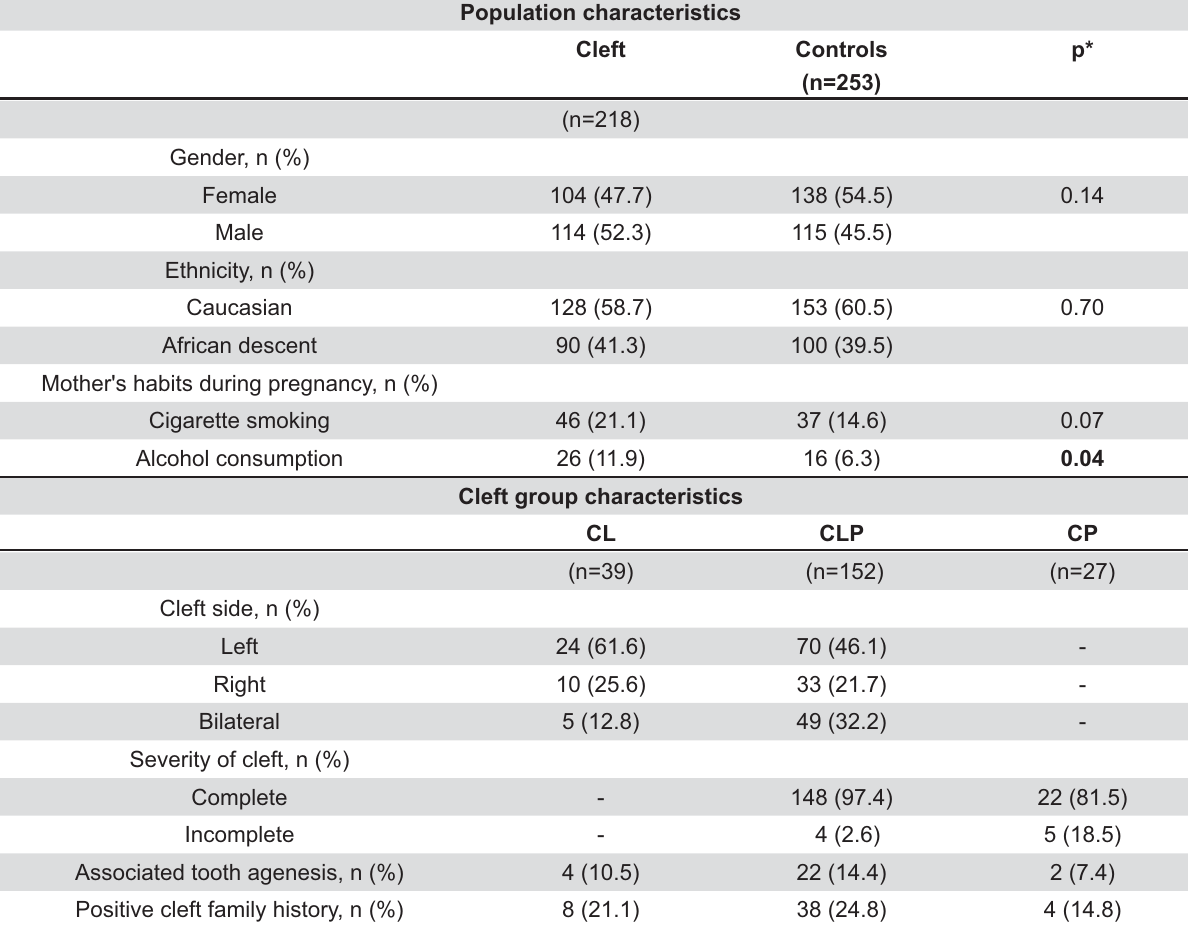
Table 1- Descriptive characteristics of cleft patients and controls